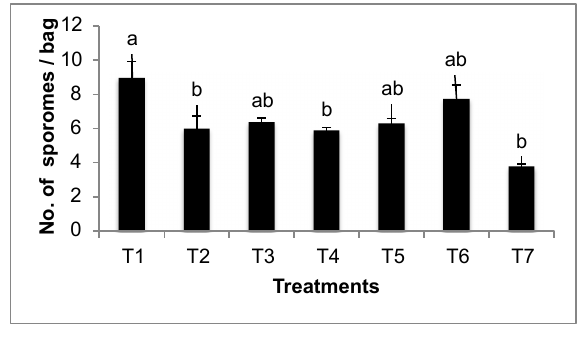
Figure 1 Sprouting: Average number of sporomes/bag for each